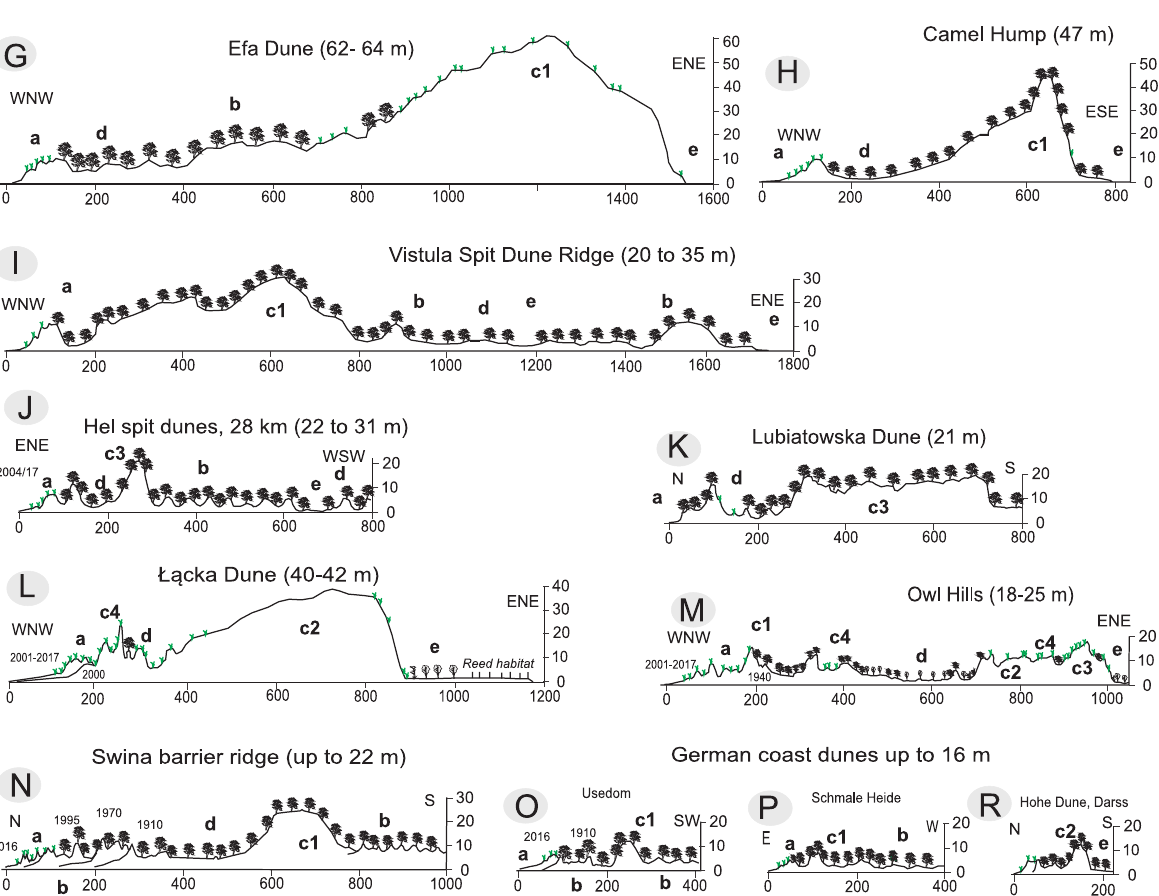
Fig. 10. The examples of highest and largest transverse dunes in each section of Baltic Sea coast (height in m a.s.l., distance in m), location on Fig. 1 ( Łabuz